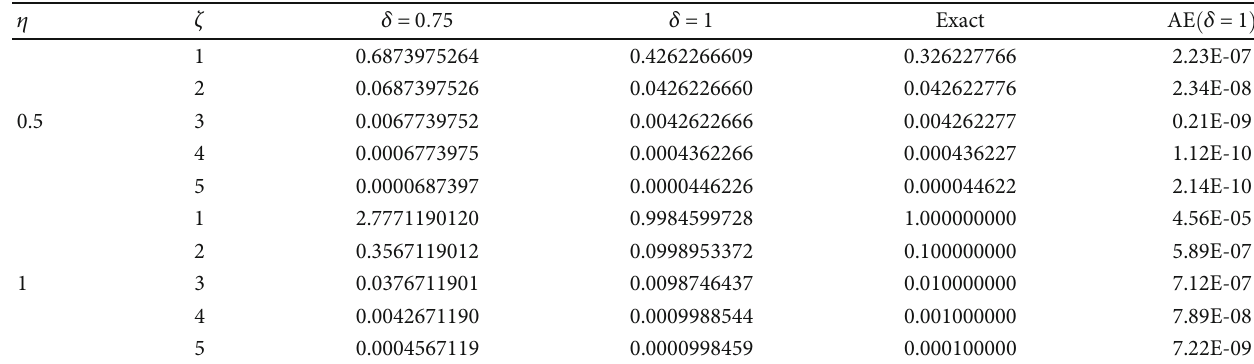
Figure 4: The di ff erent fractional-order δ graphs of Problem 3.2. Table 2: VITM at fractional-order value δ = 0 : 8 and absolute error δ = 1 of example